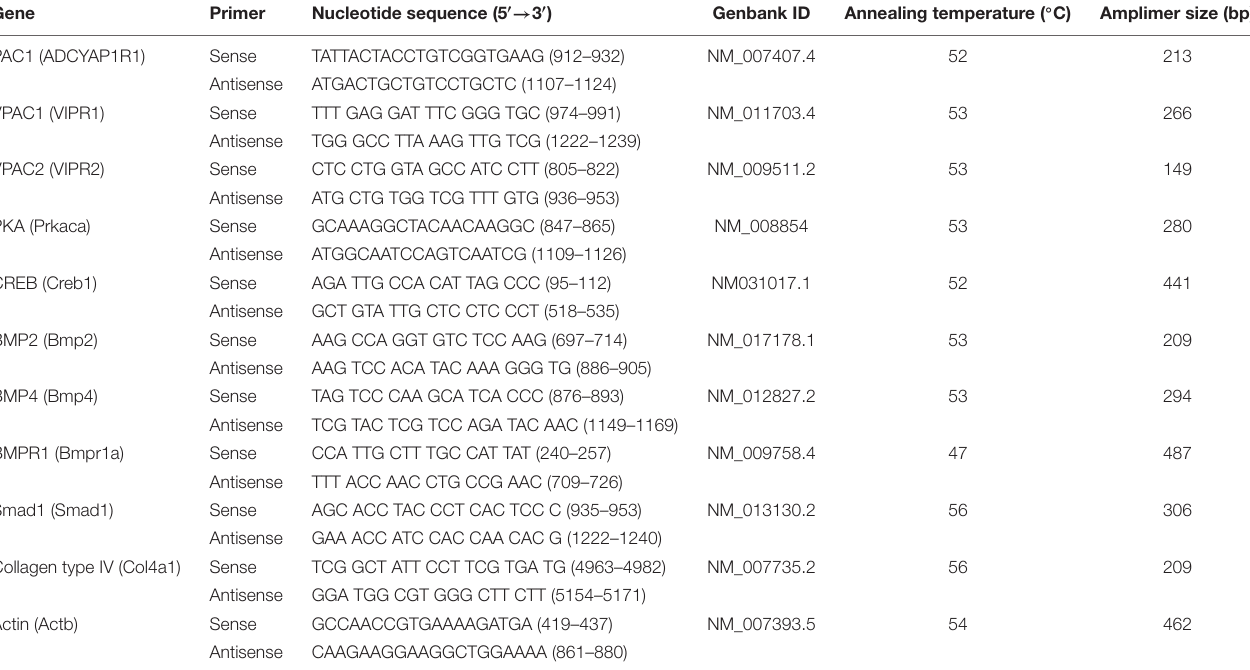
TABLE 1 | Nucleotide sequences, amplification sites, GenBank accession numbers, amplimer size, and PCR reaction conditions for each primer